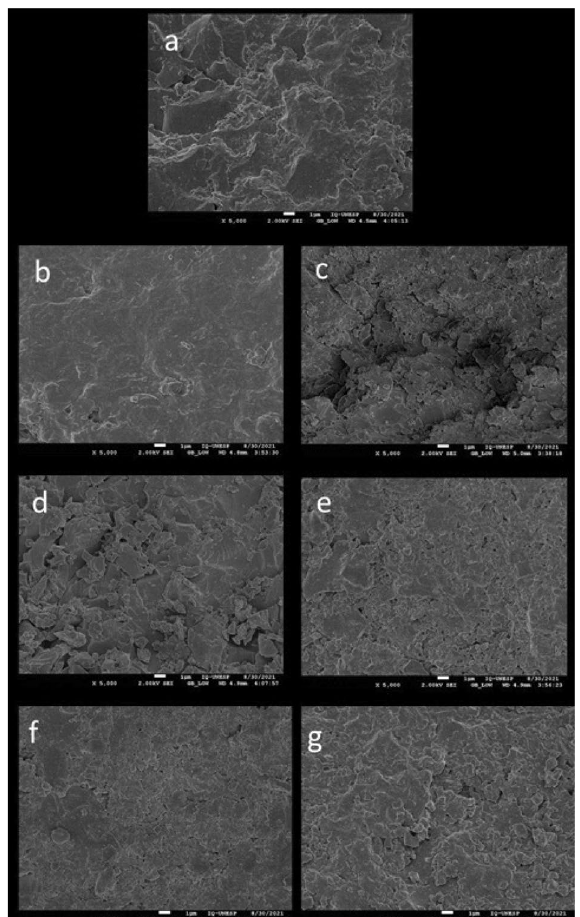
Figure 8. SEM images (5000×) of RBCs synthesized with nanoparticles: ( a ) G1: control; ( b ) G2: resin matrix + 0.3% MMt (MMt/0.3); ( c ) G3: resin matrix + 0.5% MMt (MMt/0.5); ( d ) G4: resin matrix + 0.3% GO (GO/0.3); ( e ) G5: resin matrix + 0.5% GO (GO/0.5); ( f ) G6: resin matrix + 0.3% GO–MMt (GO–MMt/0.3) and ( g ) G7: resin matrix + 0.5% GO–MMt (GO–MMt/0.5).